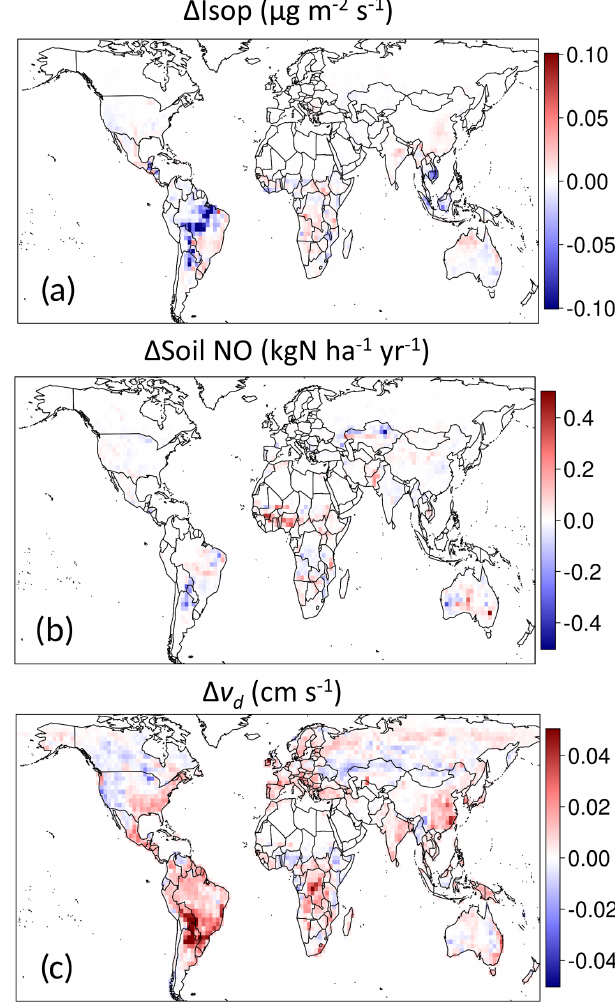
Figure 3. Changes in annual mean (a) isoprene emissions ( (cid:49) Isop), (b) soil NO emissions ( (cid:49) Soil NO) and (c) O 3 dry deposition veloc- ity ( (cid:49)v d ) due to LULCC over 1992 to